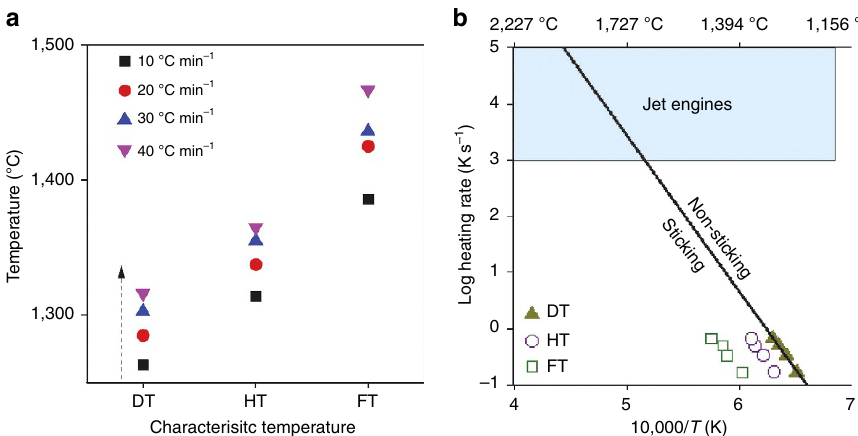
Figure 6 | Heating rate effects on volcanic ash fusion. ( a ) Mean temperature values of DT, HT and FT of Santa Marı´a volcanic ash as function of heating rate. ( b ) Thermokinetic control on the characteristic temperatures of molten ash. The line is the Arrhenian regression that best fits temperature (T) at DT, as a function of heating rate ( q ): log ( q ) ¼ 17.325 þ ( (cid:2) 5.32 (cid:3) 10 5 )/(19.144 (cid:4) T ) ( r ¼ 0.99; n ¼ 4). Extrapolation to jet engine conditions (blue box) defines the temperature and heating rate window for which ash may melt and stick to jet